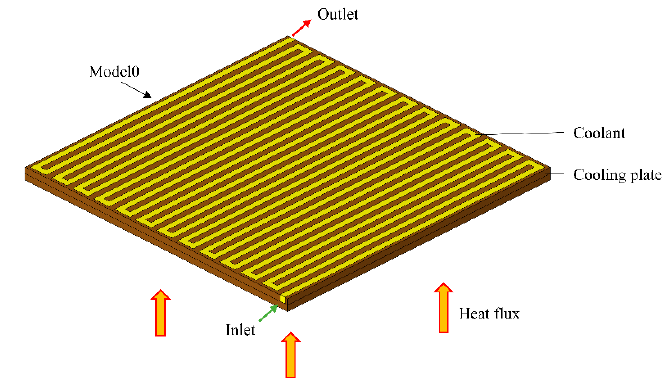
Figure 2. Calculation model of cooling plate.